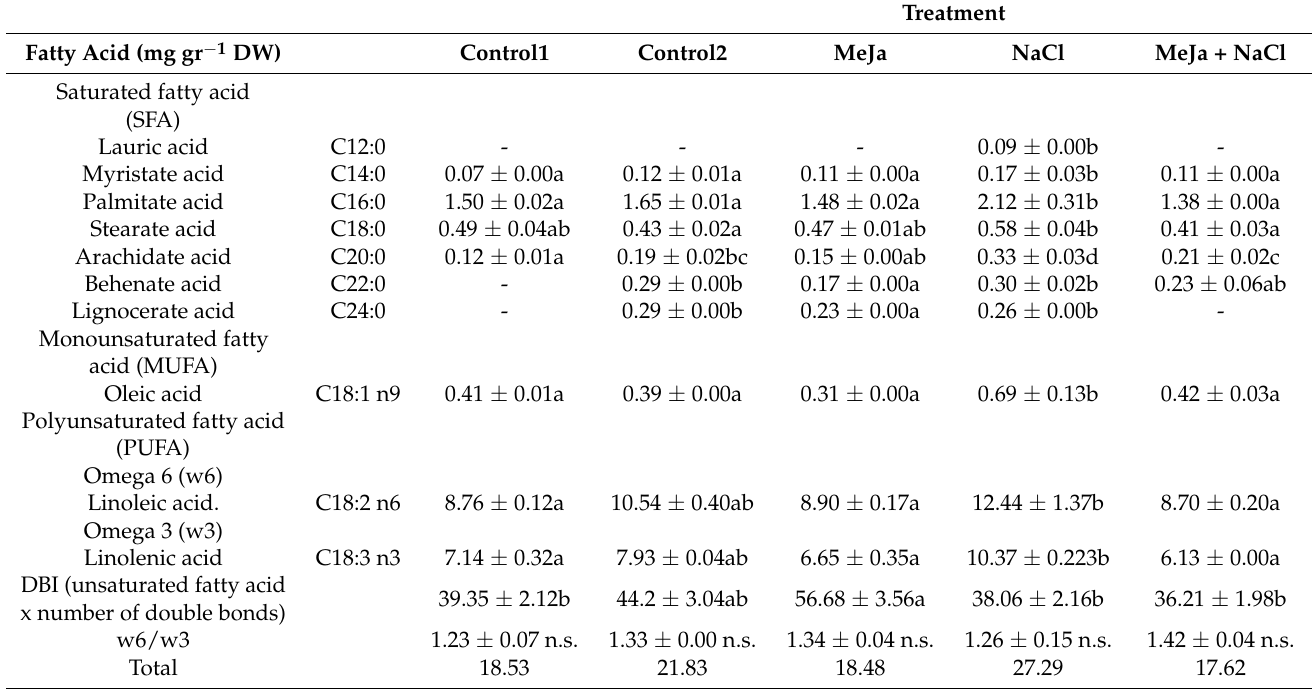
Table 4. The content of fatty acids (mg gr − 1 DW) in the leaf tissues of C. maritimum under the different treatments (Control1, Control2, NaCl, MeJa, NaCl + MeJa), ( n = 10). Rows with different letters (a, b, c) for each variable differ significantly